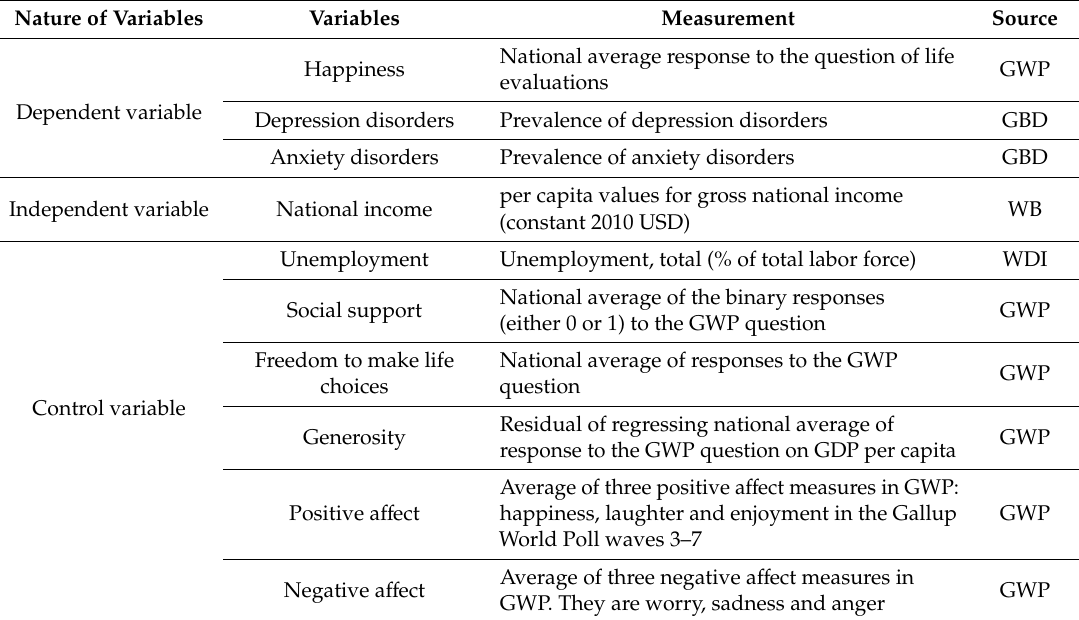
Table 1. Variables and Data